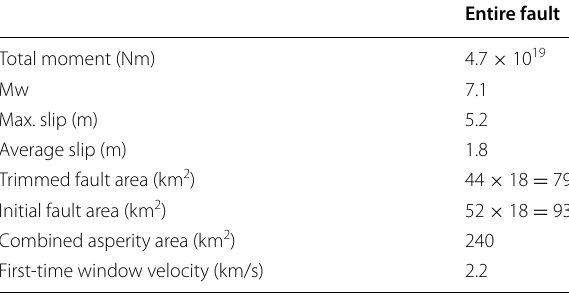
Table 2 Estimated fault